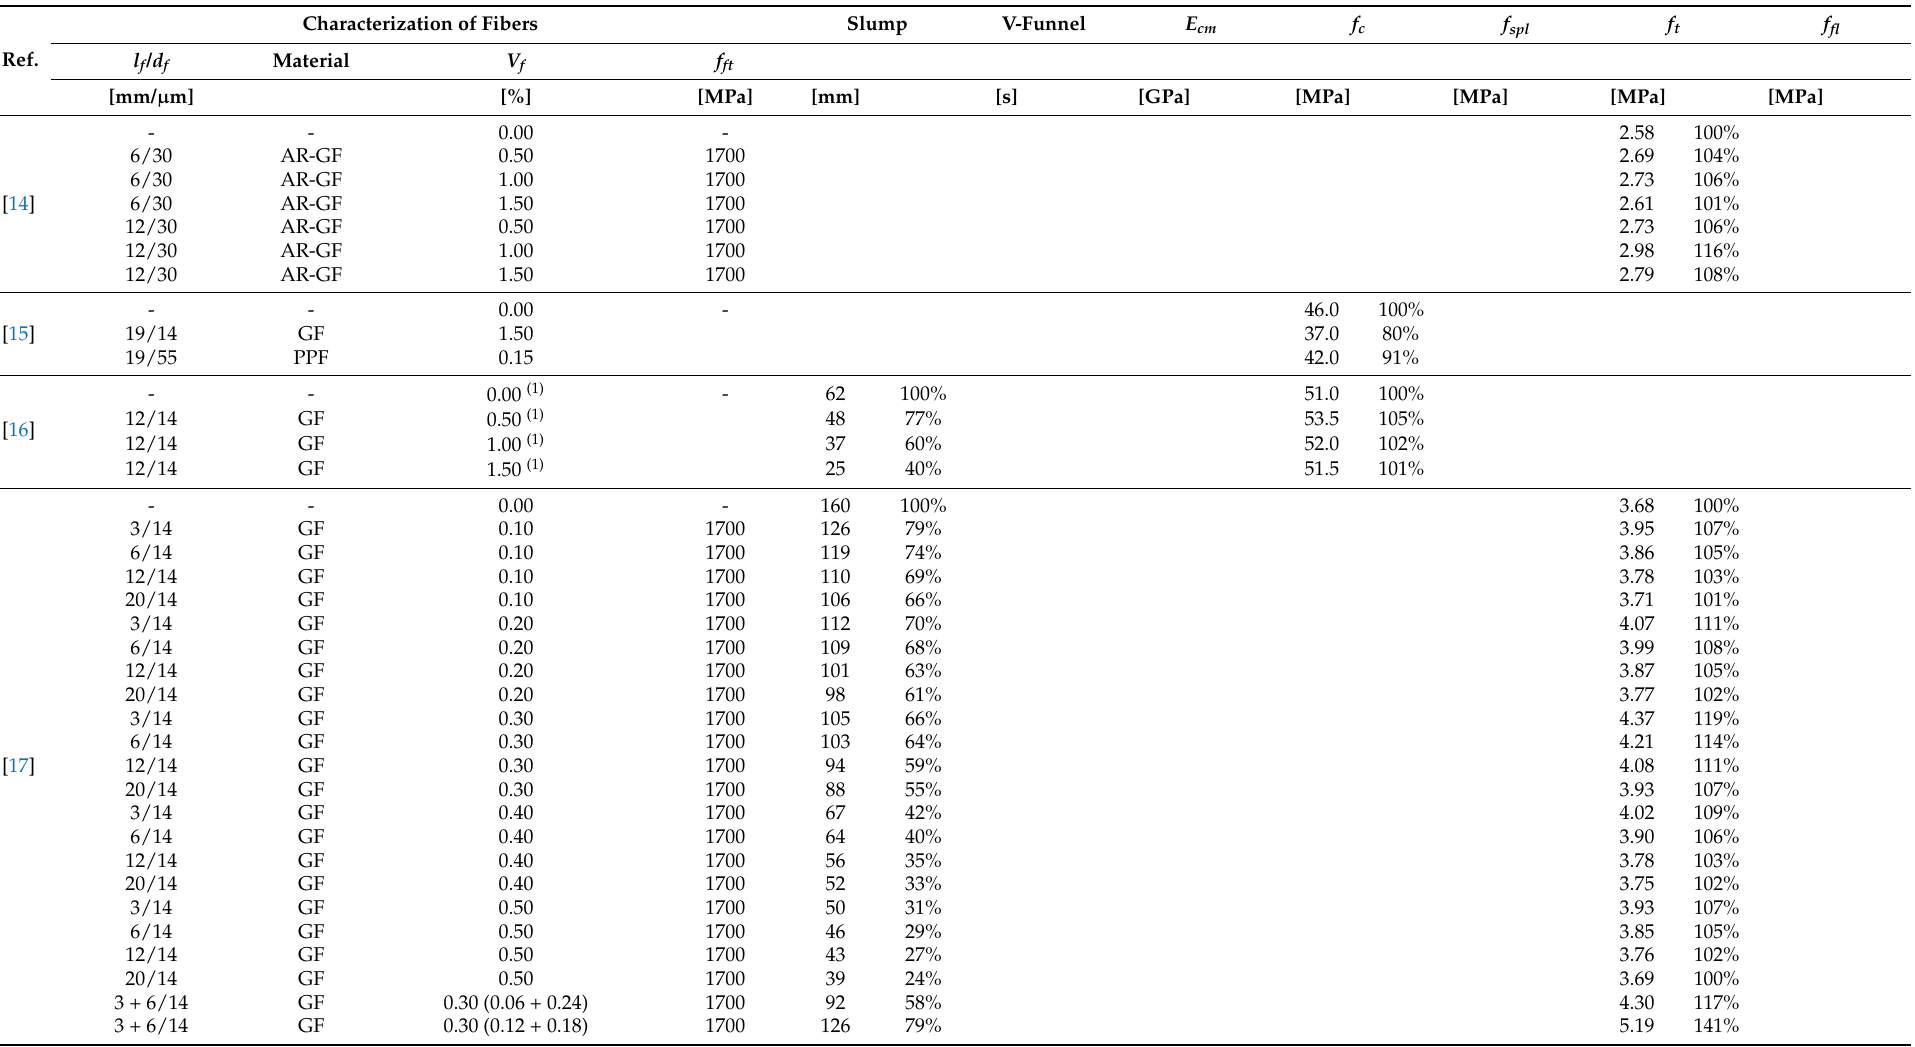
Table 4. Physical and mechanical characterization of PC and